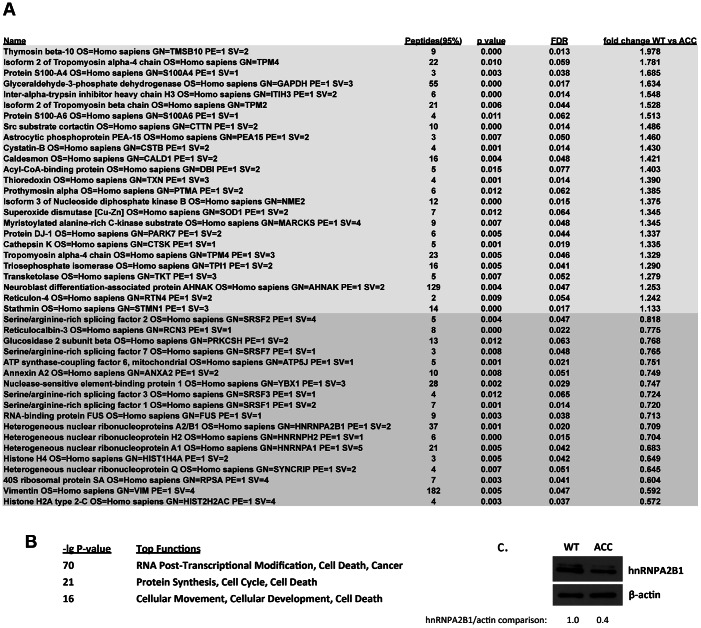
Global proteomic analysis in ACC skin fibroblasts.a. Comparative quantitative proteomic analysis with iTRAQ labeling experiments. Upregulated proteins in ACC fibroblasts are shown in the upper part of the figure and downregulated proteins in the lower part of the figure. The columns show values for the following: Peptides (95%): number of peptides identified with at least 95% confidence; raw p-value; false discovery rate (FDR), fold change of WT vs ACC mean values. b. Network analysis (Ingenuity) identified the most significantly altered networks to include top functions for “RNA-posttranscriptional modification”, “protein synthesis” and “cell cycle” (Fisher exact test –lg p-values indicated). c. Western blotting experiments confirm downregulation of hnRNPA2B1 in ACC fibroblasts compared to control fibroblasts. Relative values for bands normalized to loading control are shown.